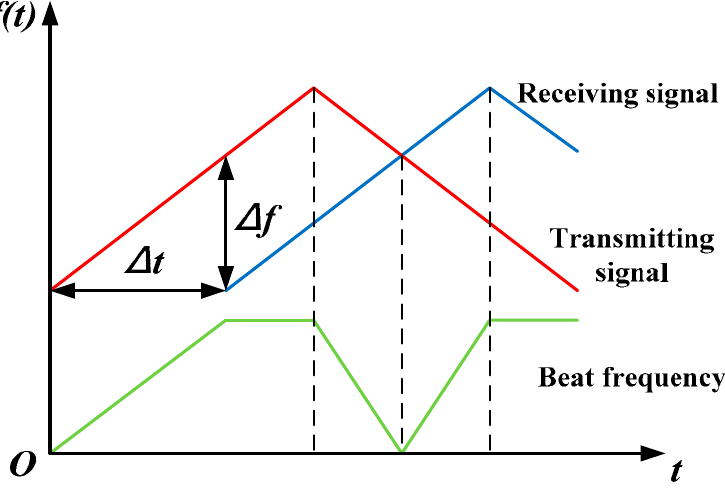
Figure 1. The brief ranging principle of the FMCW radar.